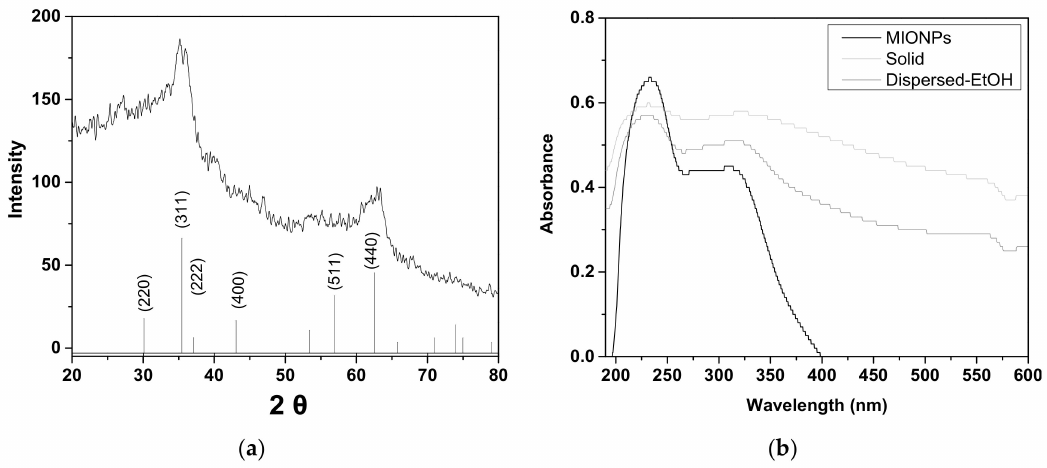
Figure 3. Spectra of MIONPs: ( a ) XRD and ( b )